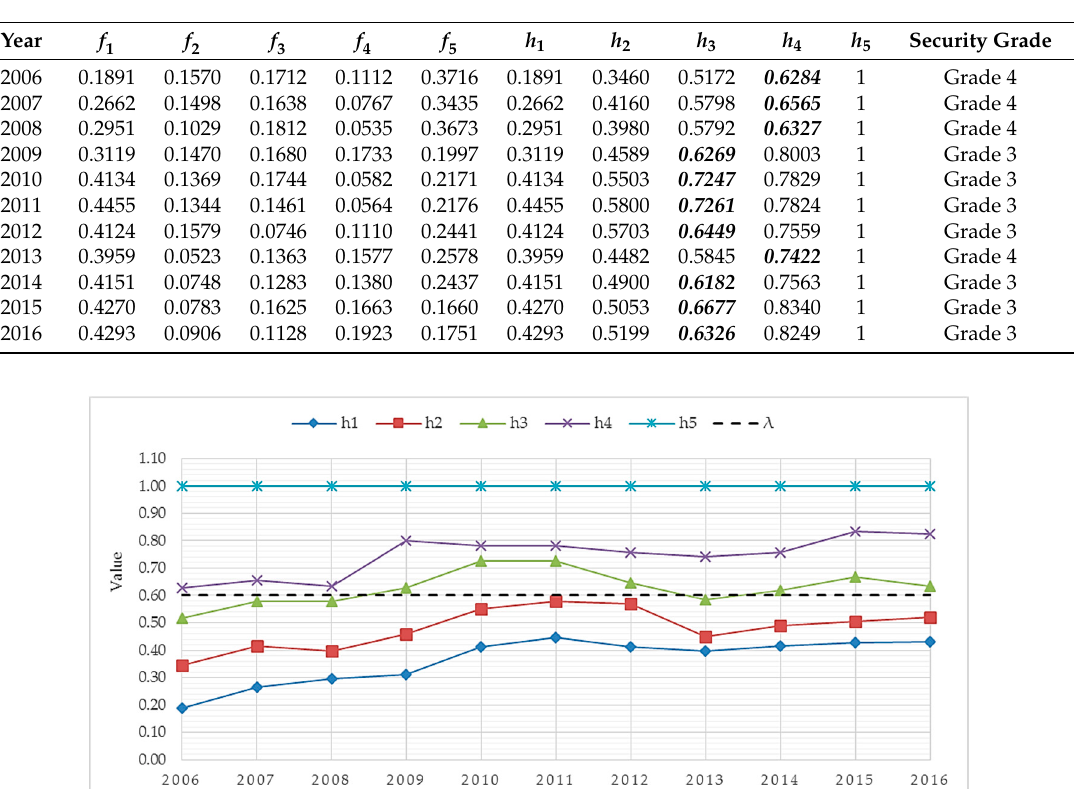
Table 4. Total connection degree and cumulative connection degree of comprehensive evaluation of water resources security.